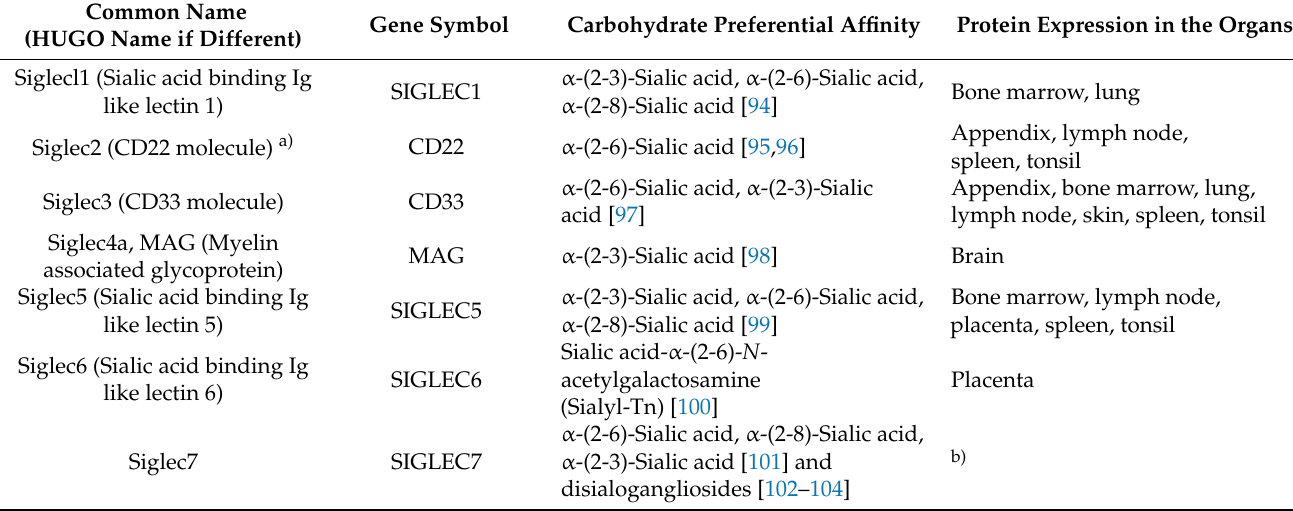
Table 6. Human I-type lectins, their carbohydrate ligands and protein expression in the